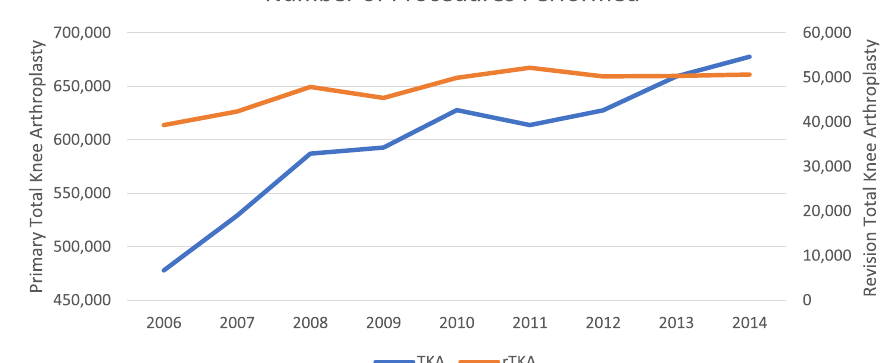
Fig. 1 Number of primary and revision total knee arthroplasties performed by year and not including data from the last quarter of